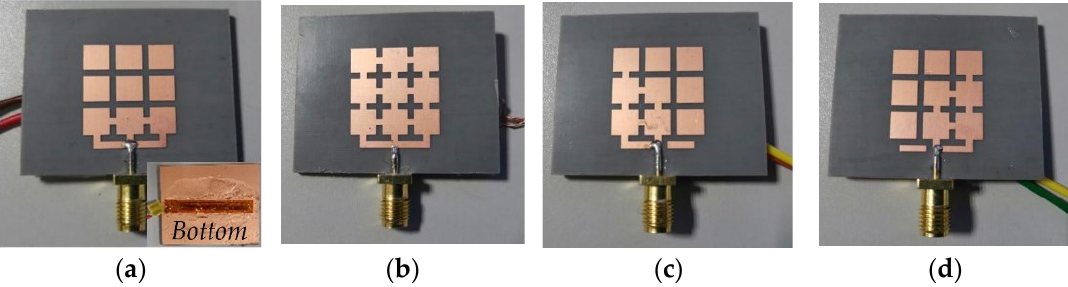
Figure 13. Physical prototypes of four reconfigurable antennas. ( a) Mode 1 antenna; ( b ) Mode 2 antenna; ( c ) Mode 3 antenna; ( d ) Mode 4 antenna.